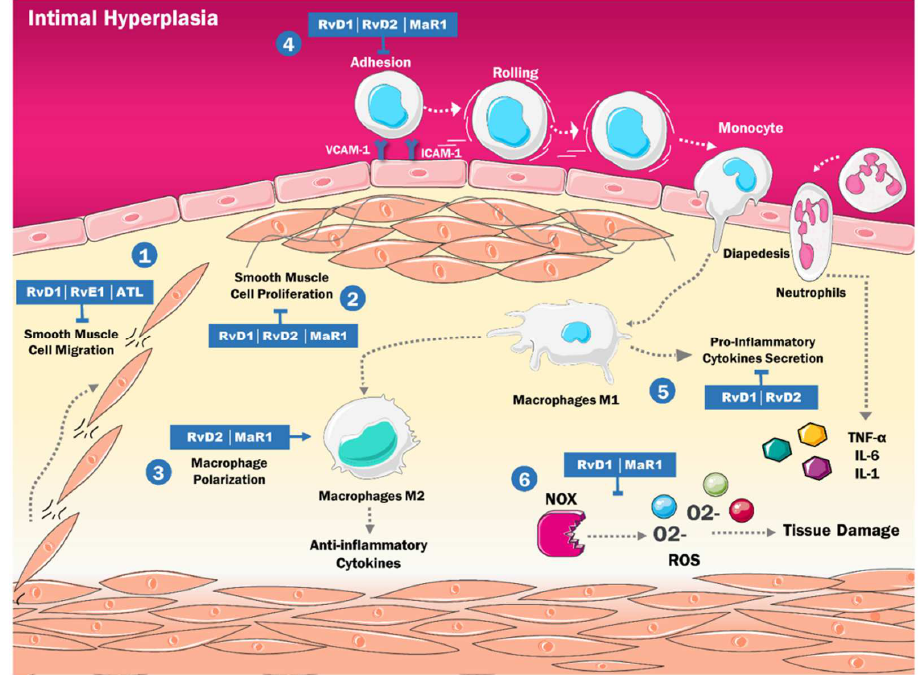
Figure 3. Mechanisms of actions of Specialized proresolving lipid mediators in intimal hyperplasia are involved in different processes: (1) Blocking the migration of VSMC in the intima; (2) Inhibiting the proliferation of VSMC in the intima; (3) Increasing Macrophage Polarization in the anti-inflammatory phenotype; (4) Interfering with the adhesion of neutrophils and monocytes; (5) Reducing the secretion of proinflammatory cytokines; (6) Decreasing production of ROS by NOX. IL-1: Interleukine 1. IL-6: Interleukine 6. TNF-α: Tumor Necrosis Factor Alfa. M1: Classically activated macrophages. M2: Alternatively activated macrophages. RvD: Resolvins D Serie. MaR: Maresins. RvE: Resolvins E Serie. ATL: Aspirin-triggered lipoxin. NOX: Nicotinamide adenine dinucleotide phosphate-oxidase ROS: Reactive oxygen species. O2-: Superoxide. VCAM-1: Vascular cell adhesion molecule 1 ICAM-1: Intercellular adhesion molecule 1.